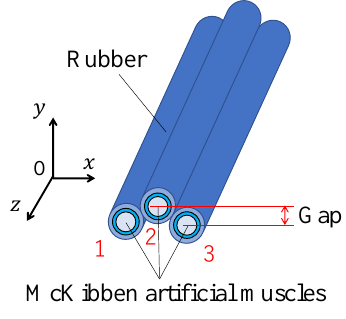
Figure 1. The structure of 3-DOF micro-hand.